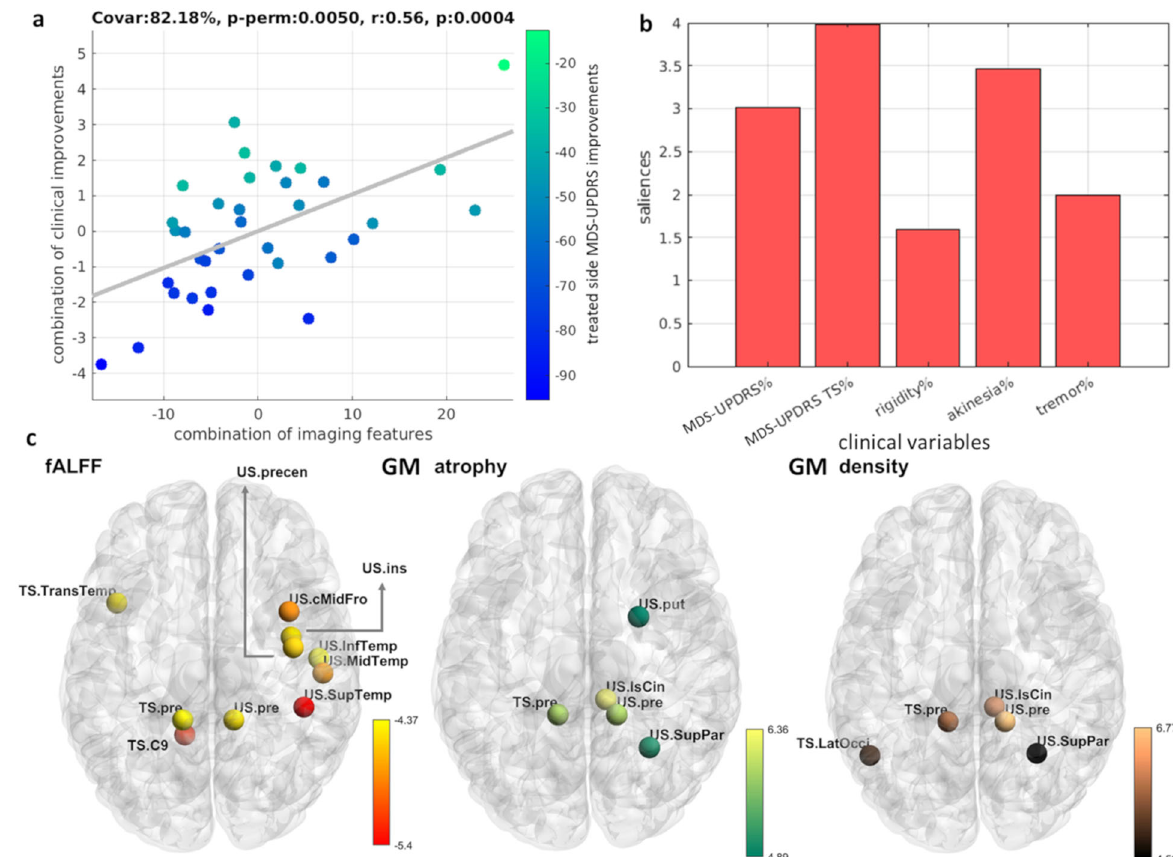
Fig. 3 Baseline imaging association with tcMRgFUS-subthalamotomy outcomes. a The combinations between imaging features and clinical variables are signi fi cantly correlated. Each dot represents one subject and is color-coded with the MDS-UPDRS changes percent (speci fi c to the treated side). b Contribution of clinical outcomes (month-4 visit) to the observed association with the baseline imaging. Each bar indicates the salience/importance of the variables (i.e. bootstrapping ratio). c The contributions of top 5% imaging regional features. Baseline fALFF, gray matter atrophy, and gray matter density contributions are shown on the left, middle, and right, respectively. Color bars indicate salience/ importance (i.e. bootstrapping ratio) in each component. Of note, as atrophy values are negative by de fi nition, bigger absolute values represent greater atrophy. [fALFF fractional amplitude of low-frequency fl uctuation, US untreated side, TS treated side, GM gray matter; the full name of each region is included in Supplementary Table